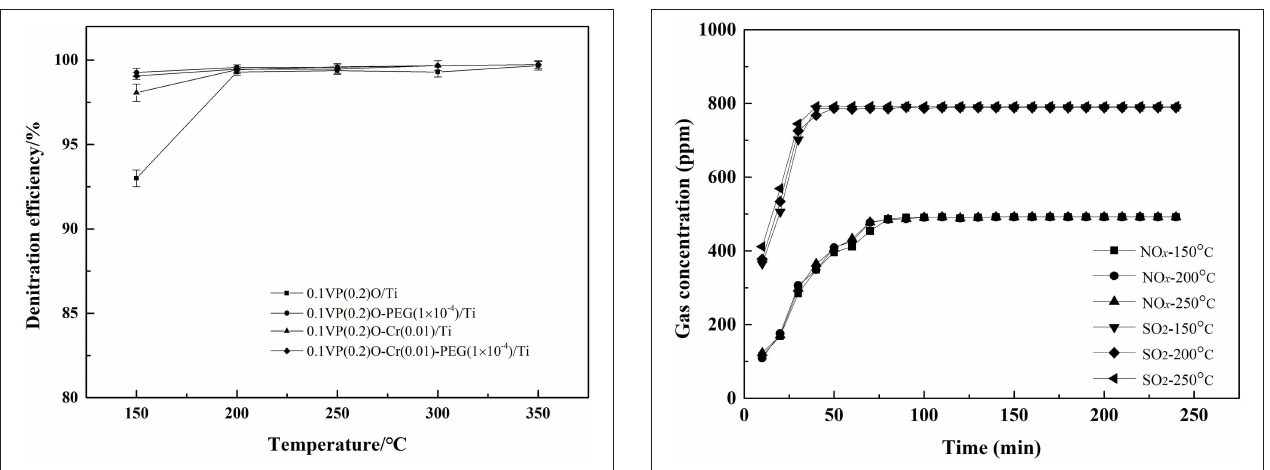
FIGURE 2 | Denitration efficiency of the supported VPO catalysts.